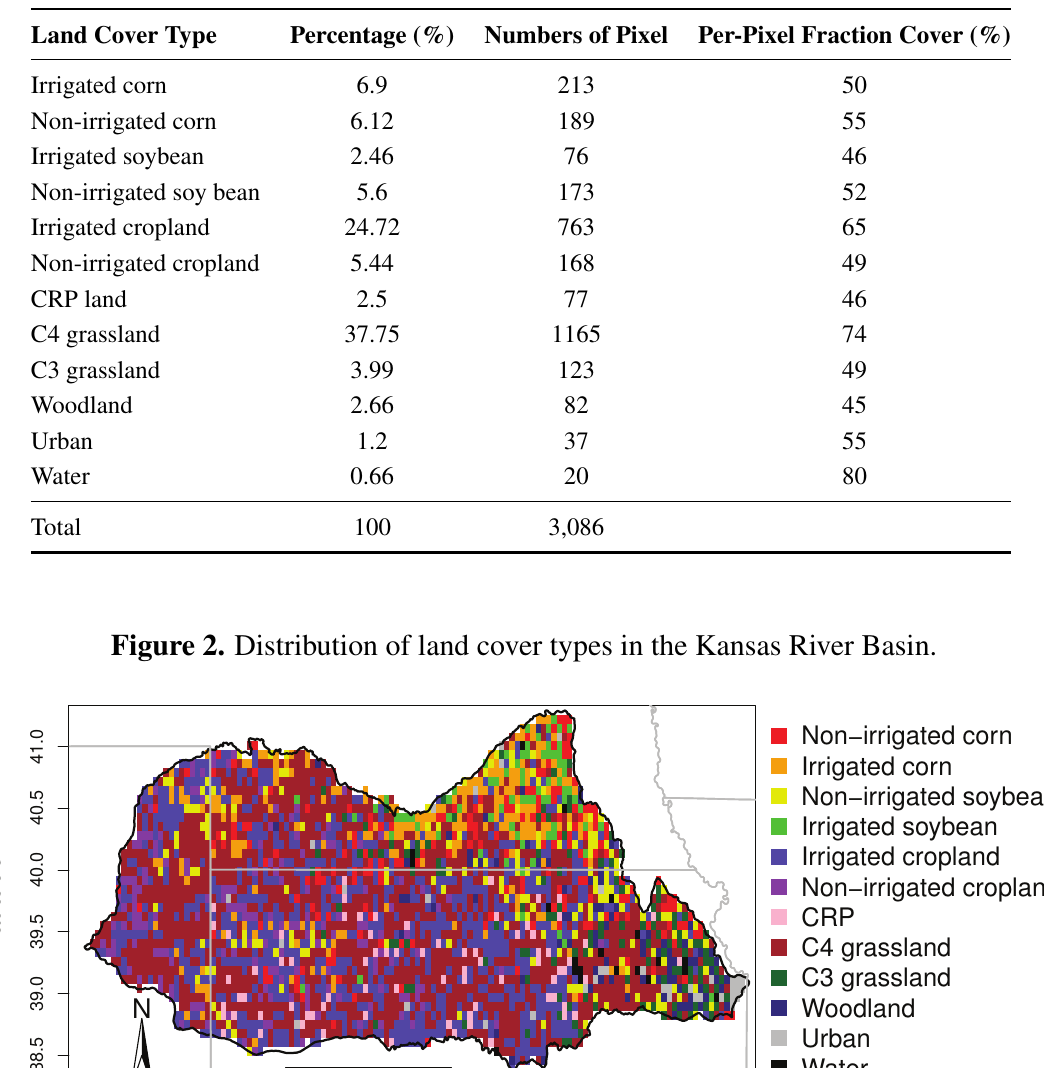
Table 1. Land cover types, percentage, numbers of pixel and per-pixel fraction cover (the average of the aggregation from the 1-km grid to the 8-km grid) of the 2005 Kansas Land Cover Patterns Level IV map.